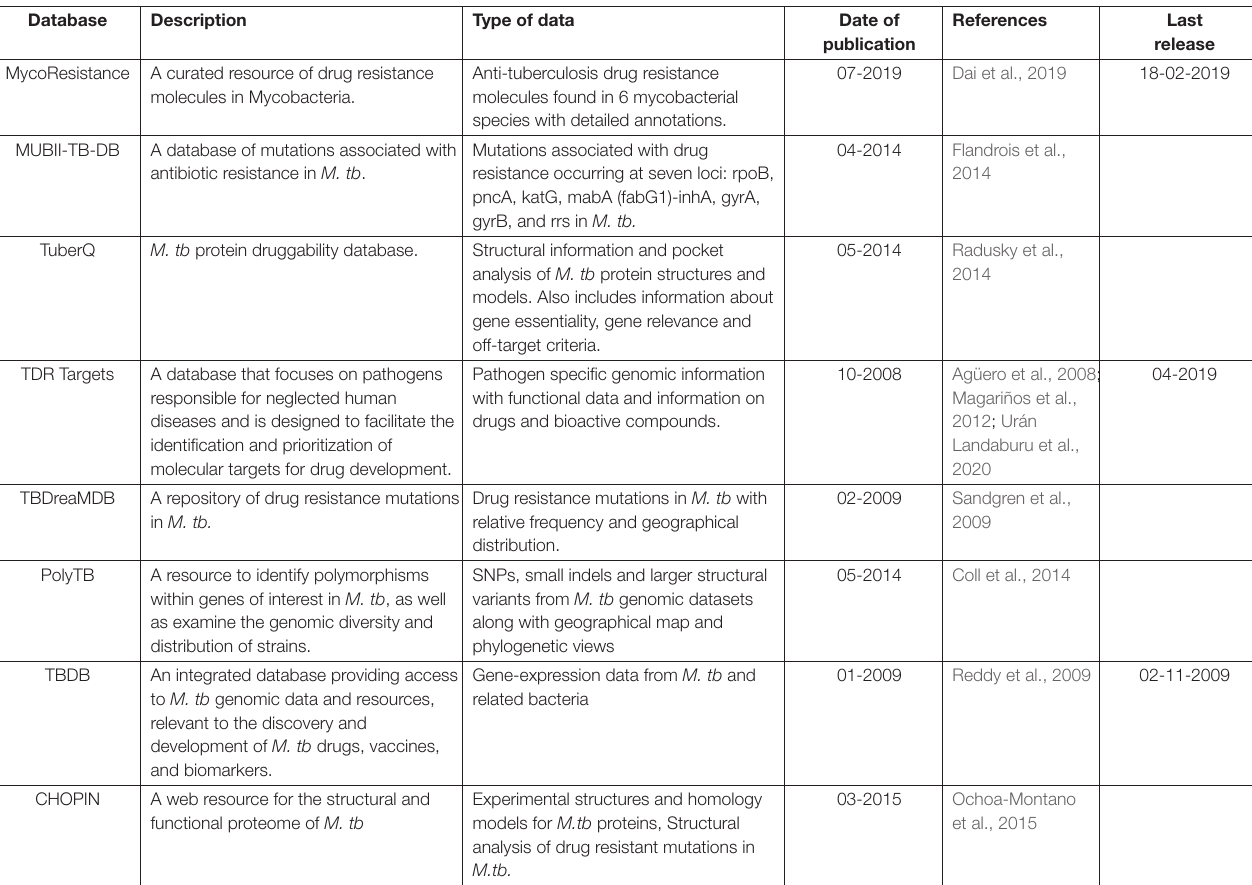
TABLE 1 | List of databases/resources for structural and/or mutational analyses in